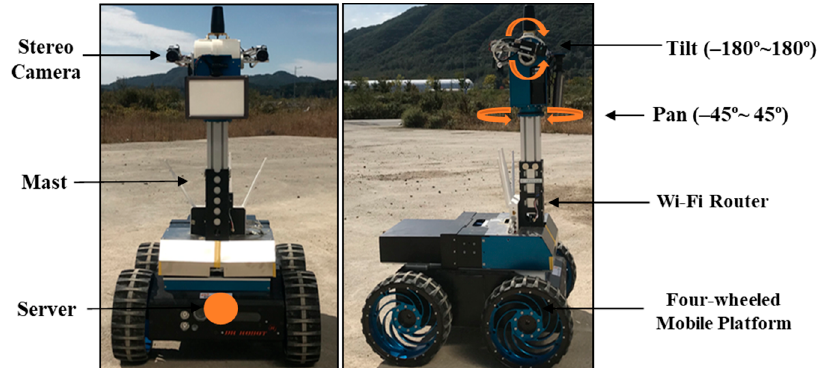
Figure 2. Overview of a robotic mapping system.